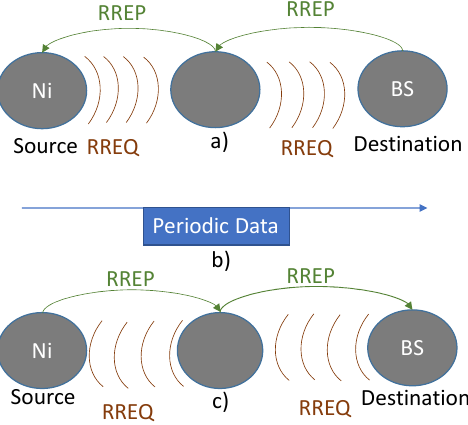
Figure 6. Routing Phase: ( a ) AODV protocol; ( b ) data direction; and ( c ) modification for our system.